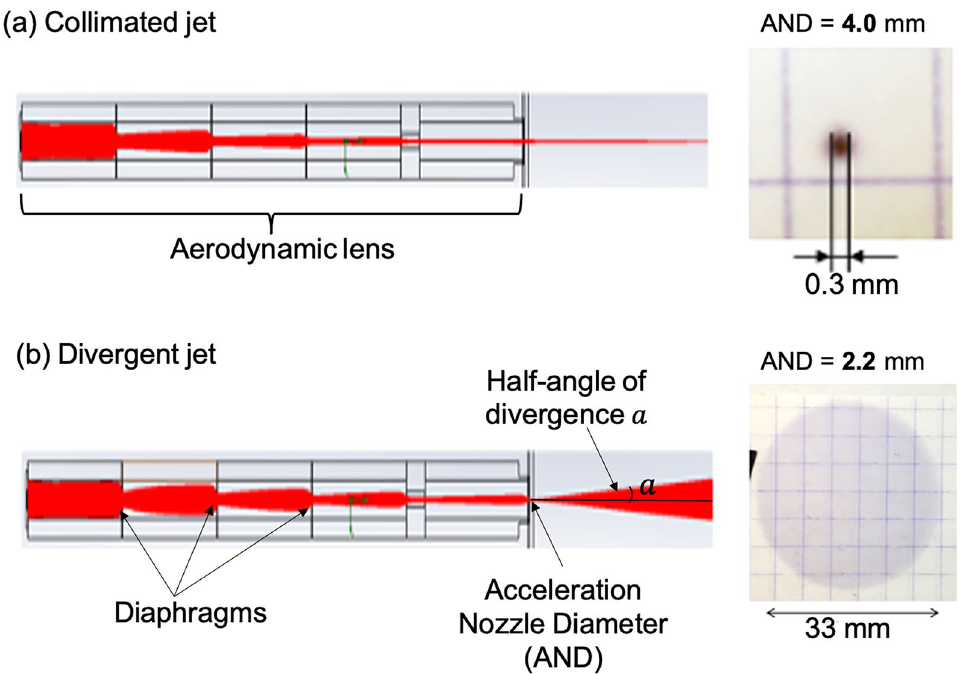
Figure 1. Numerical simulations of trajectories of 15 nm gold nanoparticles (red) in an aerodynamic lens (left side) and corresponding experimental results (right side) of simple nanoparticles deposits on a paper substrate for two different acceleration nozzle diameters (AND) (4 mm in ( a ) and 2.2 mm in ( b